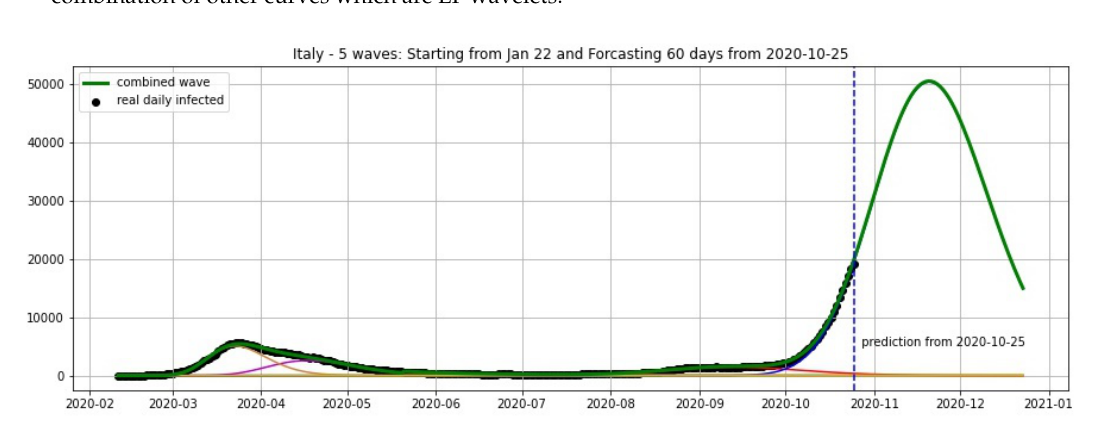
Figure 9. Germany: fitting and forecasting from 19 October with 5 wavelets. The green curve is the combination of other curves which are EF wavelets.